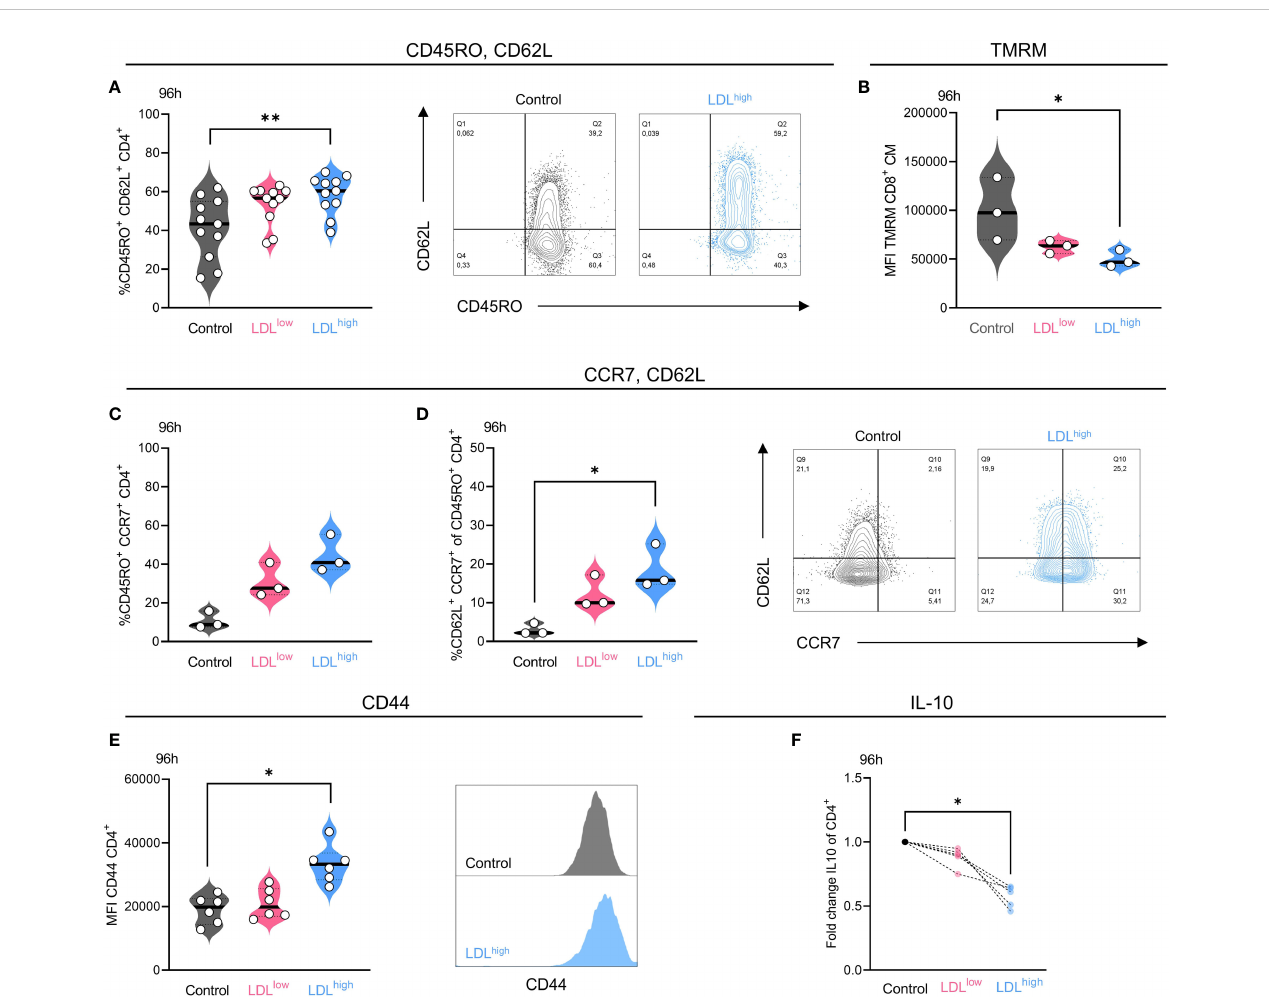
FIGURE 2 LDL high signi fi cantly enhanced the fraction of CD4 + T cells with a central memory (T CM ) phenotype after 96 h. CD4 + T cells were freshly isolated and stimulated with anti-CD3/CD28 beads, IL-2 and treated with different LDL dosages (LDL low = 50 µg/ml and LDL high = 200 µg/ml) versus medium control. (A) LDL high signi fi cantly enhanced the fraction of CD45RO + /CD62L + cells in the CD4 + T cell subset after 96 h. Representative FACS plots present the percentage of CD45RO + and CD62L + cells in the presence of medium control versus LDL high . (B) TMRM was reduced in CD8 + T cells with a